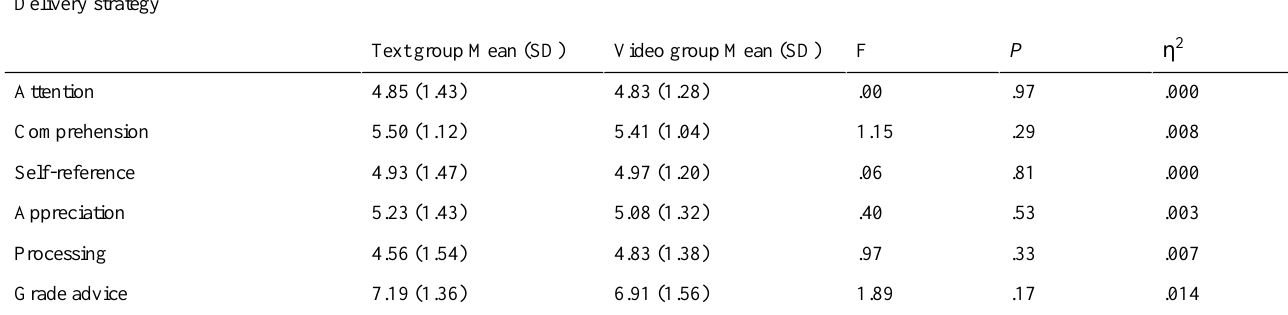
Table 3. Differences in variances of delivery strategy with regard to message-processing mechanisms